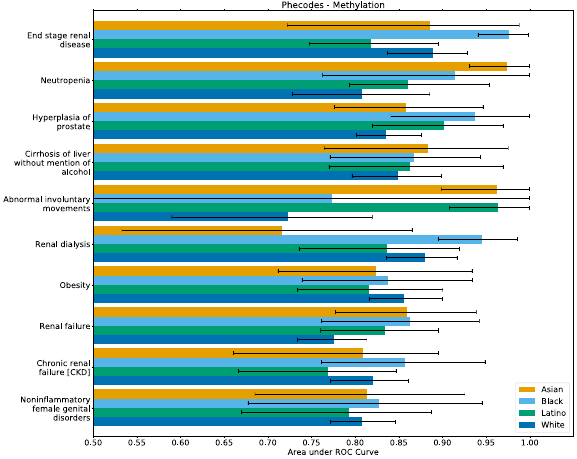
Fig. 5 Best methylation-imputed Phecodes within ancestral populations. After training a model on the entire heterogeneous population of individuals, we evaluated the predictive performance within each population separately. We observed only 6 (of 60)